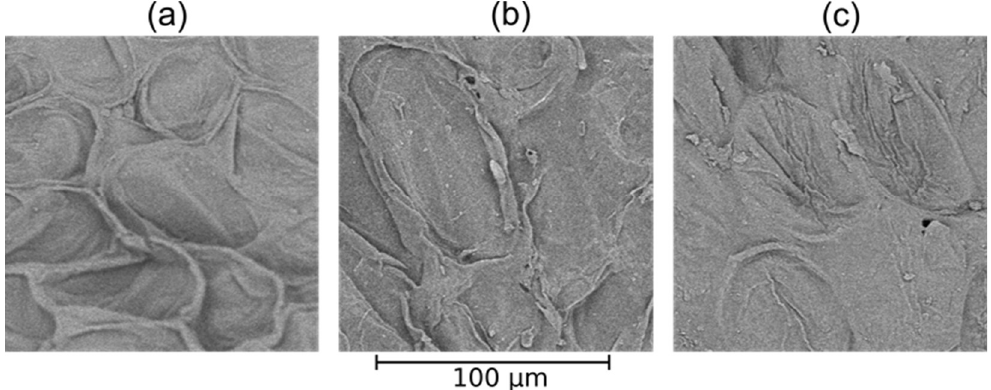
Figure 7. SEM images of Beta vulgaris at 1000× magnification. ( a ) Control (water); ( b ) PAW 5′; ( c ) PAW 20′.